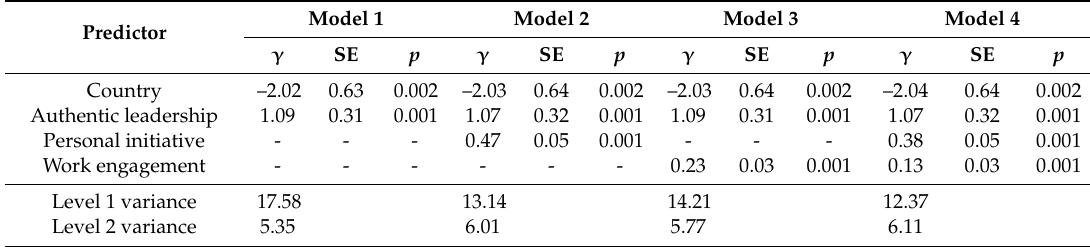
Table 3. Results of hierarchical multilevel modelling explaining employee innovative behaviour. Model 1 Predictor